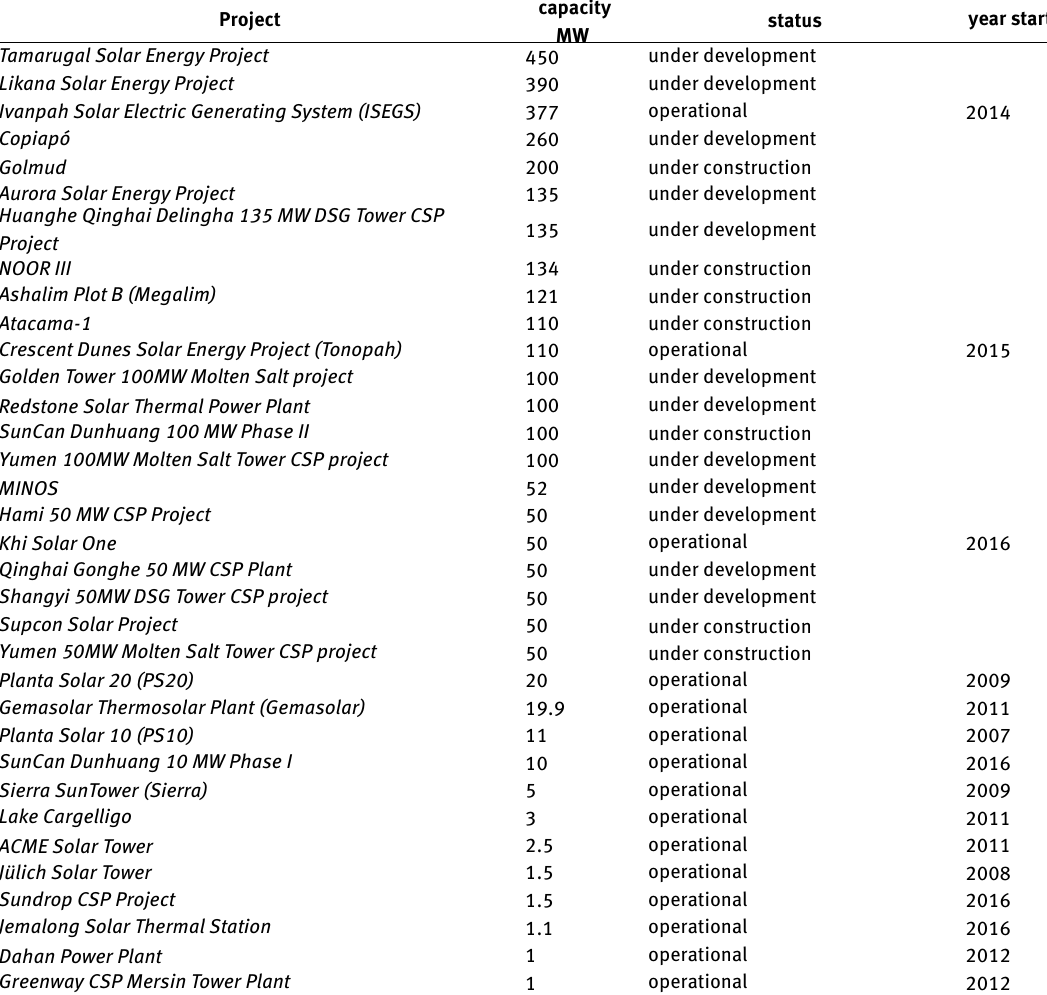
Table 1: List of solar power tower projects (from